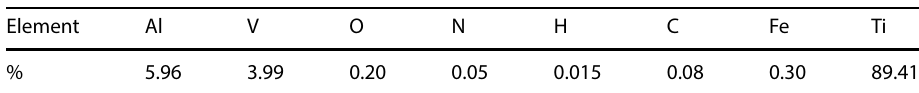
Table 1 Ti6Al4V alloy— chemical composition